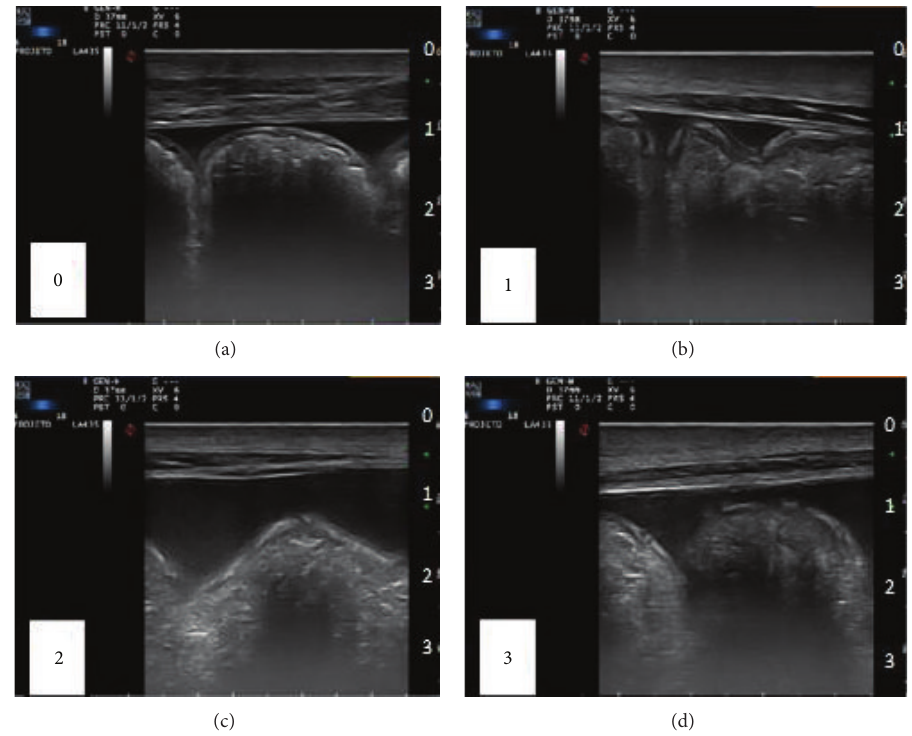
Figure 2: Longitudinal image of horses ventral abdomen from both groups. Demonstrative Scheme graduation of peritoneal fluid echogenicity, being 0 (normal), 1 (slight increase), 2 (moderate increase), and 3 (moderate increase associated with the presence of cellular